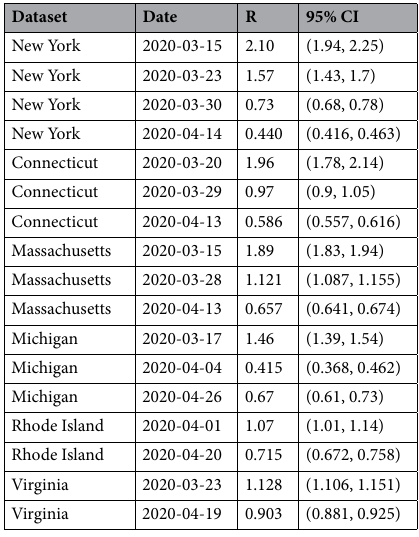
Table 1. Values of R t for each dataset and times of R t change.